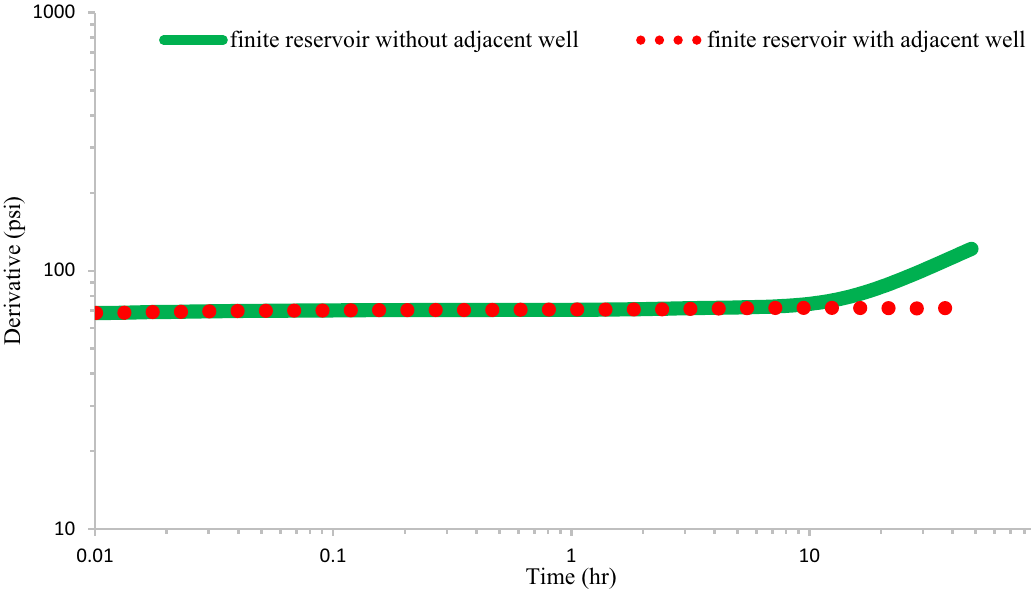
Fig. 18 Pressure derivative plots in log–log scale of scenario No. 7 on the with adjacent well and without adjacent well in finite